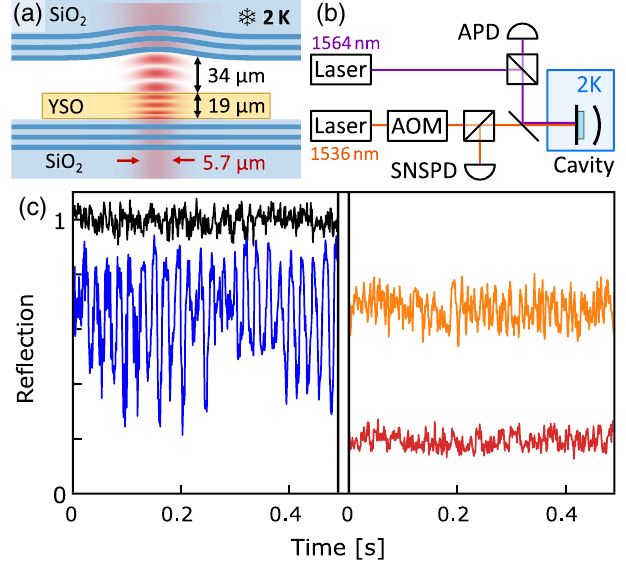
FIG. 1. Experimental setup. (a) Fabry-Perot resonator (not to scale). A stable cavity mode (red) with ∼ 46 ð 8 Þ % out-coupling efficiency toward one side is obtained by embedding a 19 ð 1 Þ μ m thin membrane of erbium-doped YSO (orange) between two dielectric mirrors (blue layers of alternating refractive index). (b) Optical setup. The cavity is mounted at 2 K in a closed-cycle cryocooler (blue box). It is probed with a faint laser field, polarized along the D 1 axis of YSO, and on resonance with the transition of erbium dopants around 1536.4 nm. It is switched by an acousto-optical modulator (AOM) and detected by a superconducting single-photon detector (SNSPD). A second laser field at 1564 nm is detected with an avalanche photodiode (APD). It is resonant with another longitudinal resonator mode and can be used for resonator stabilization. (c) Resonator stability over time. Off-resonant light is fully reflected from the cavity (black). Without active stabilization (left-hand panel), vibrations lead to a fluctuating signal when tuned on resonance (blue). With thermooptical feedback (right), the cavity frequency can be stabilized to the side (orange) or bottom (red) of the